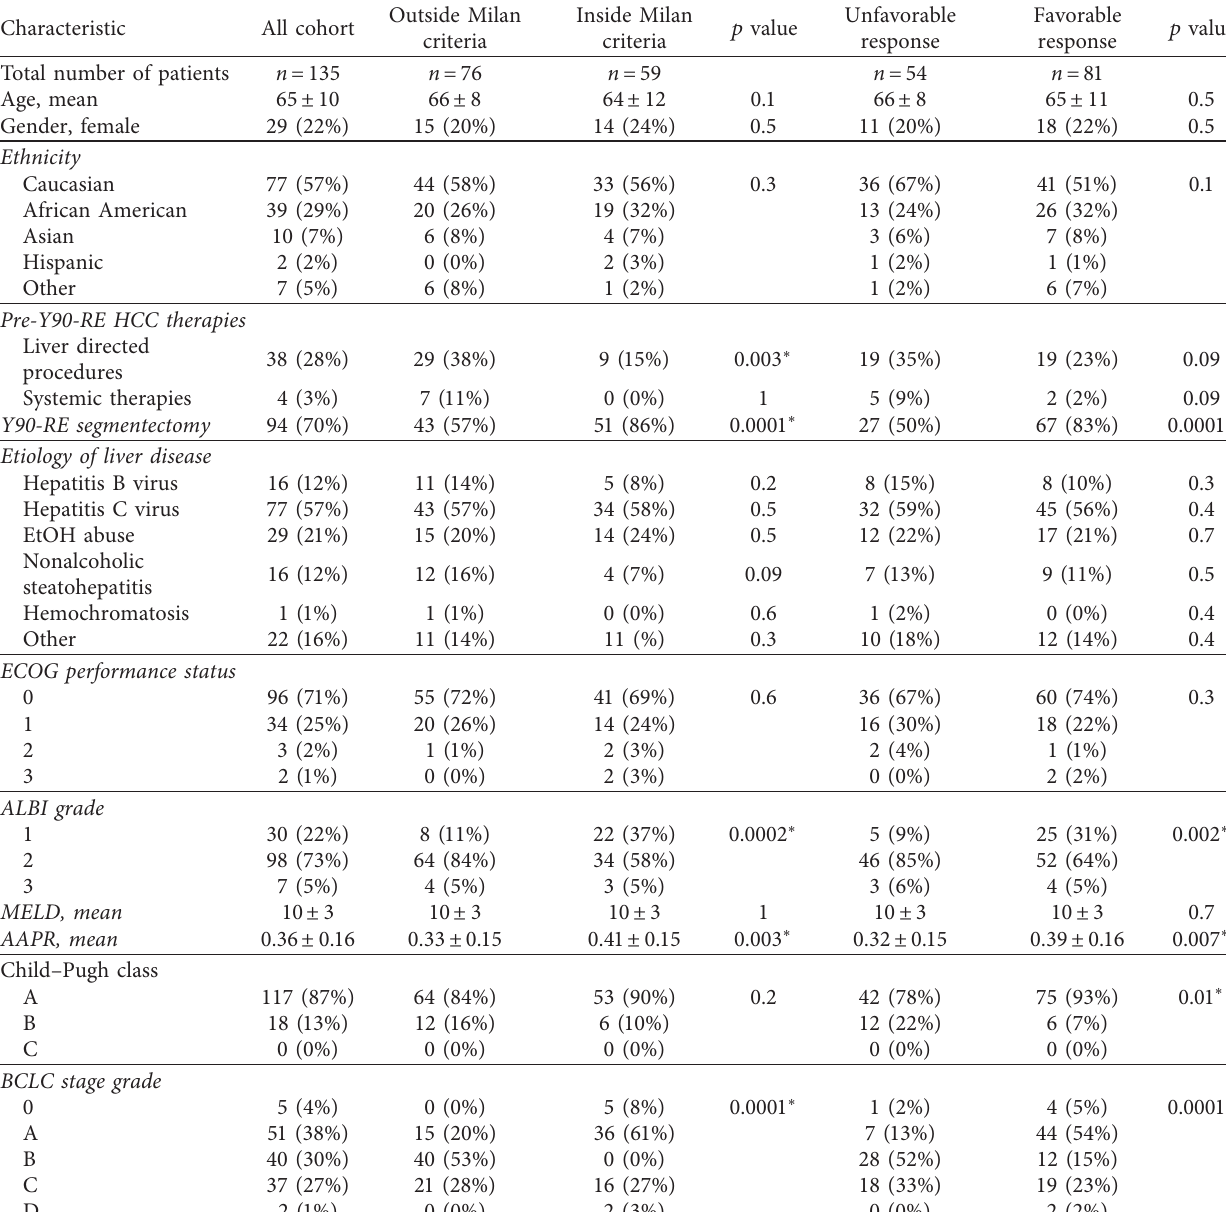
Table 1: Baseline demographics and clinical